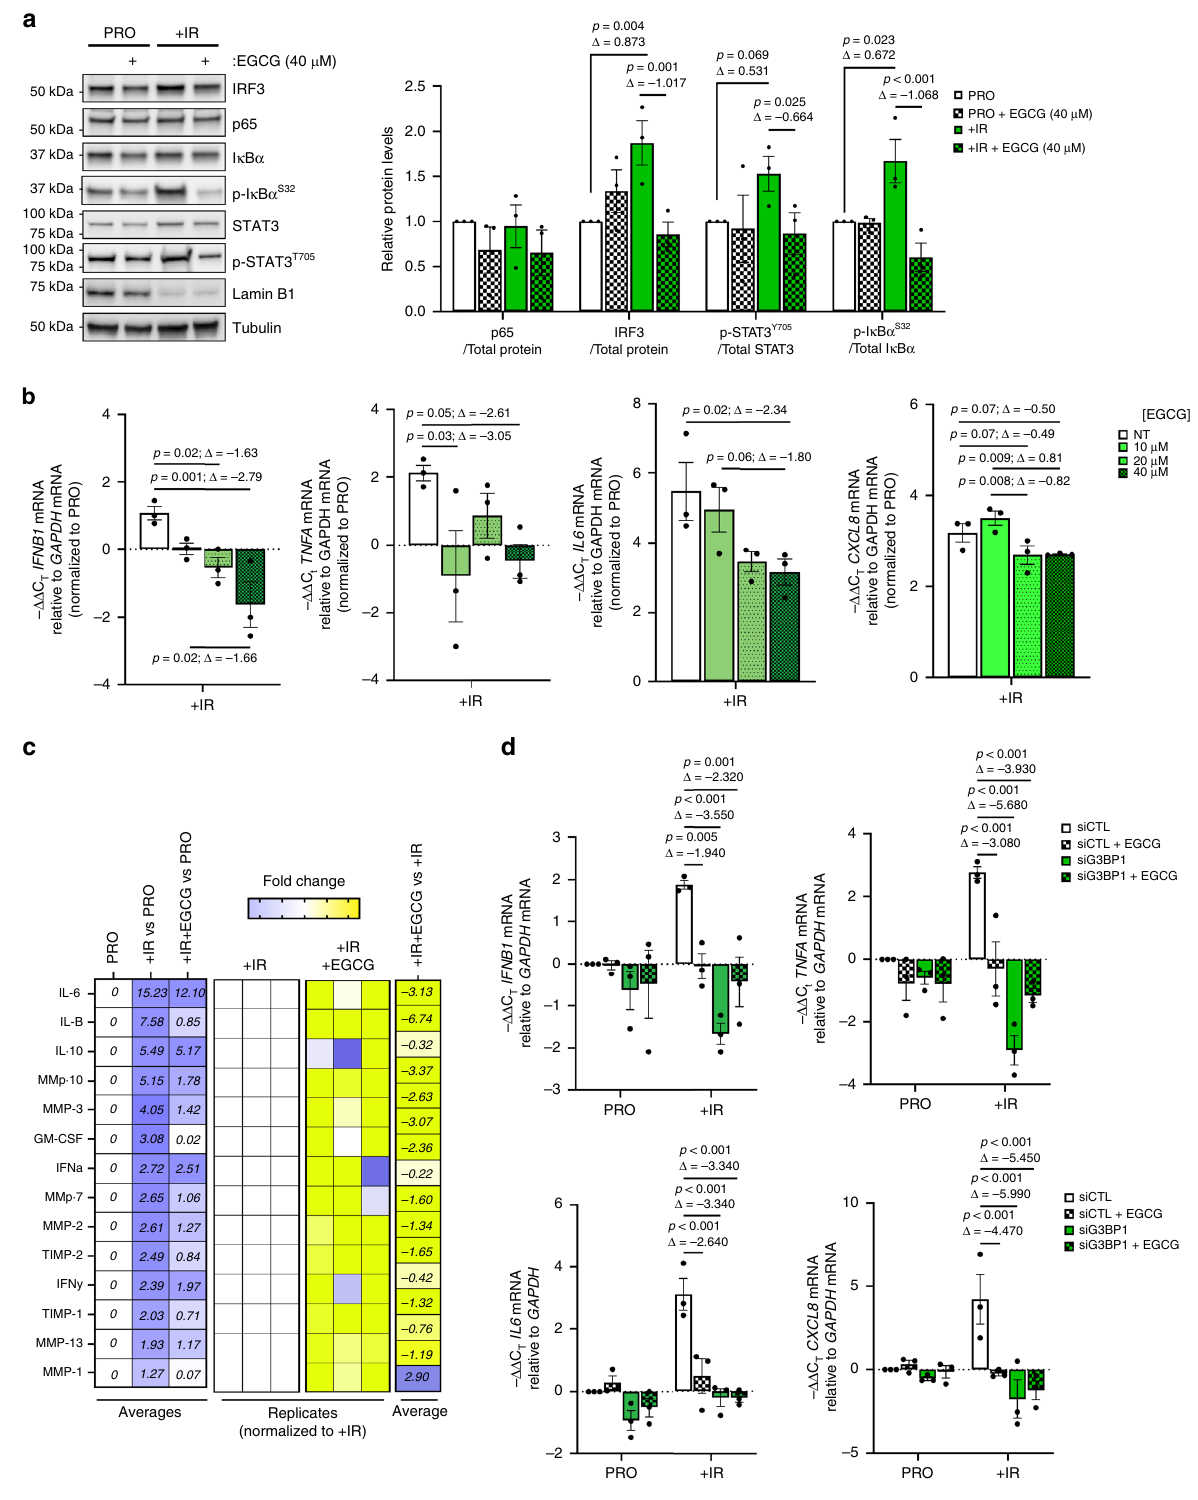
with C 12 FDG for 2h. Before fi xation, cells were stained with DAPI and immu- no fl uorescence was performed using the Zeiss Axio Observer.Z1. For